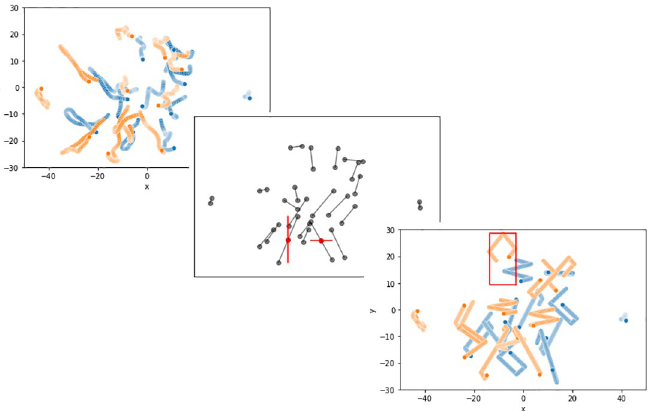
Fig 2. Trajectories of virtual players over time in a STRU and UNSTRU situations. In each plot, the axes represent the coordinates of the soccer field in meters with the origin at the center of the field. Ticks and units have been removed from the x and y axis of the central plot for clarity. Top Left) Original STRU situation: the virtual players followed real game trajectories. The orange trajectories correspond to the players of the team carrying the ball. The blue trajectories are those of the players of the opposing team. Center) From STRU to UNSTRU situation, virtual players trajectories were removed, only initial and final positions were maintained. The initial and final positions are gray dots. Each final position is connected to its initial position by a gray line, just for this illustration. The maximal distances on field length and field width (in red) that separate an initial position to the corresponding final position were used to dimension an imaginary box with an additional margin of 1m by side. This imaginary box was used to constrain virtual players’ path. If an imaginary box exceeded the field limits, its dimensions were reduced to match the boundaries of the virtual soccer field. Bottom Right) Computed UNSTRU situation: A random starting direction was given to each virtual player which then moved in a straight path at constant speed and only changed direction when hitting a wall of its imaginary box (in red). The orange trajectories correspond to the players of the team carrying the ball. The blue trajectories are those of the players of the opposing team.